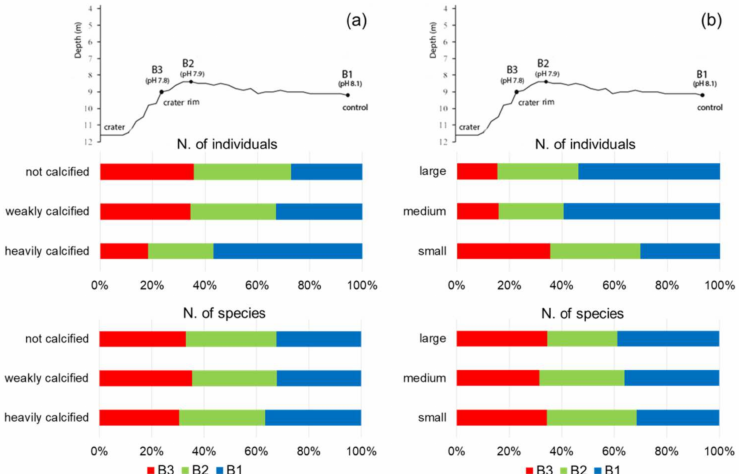
Figure 5. Relative proportion of the number of individual and species for: ( a ) calcification level categories: heavily calcified, weakly calcified, and non-calcified; ( b ) adult size: small (<1 cm), medium (1–5 cm), and large (>5 cm) along the OA gradient off the Bottaro crater vents.